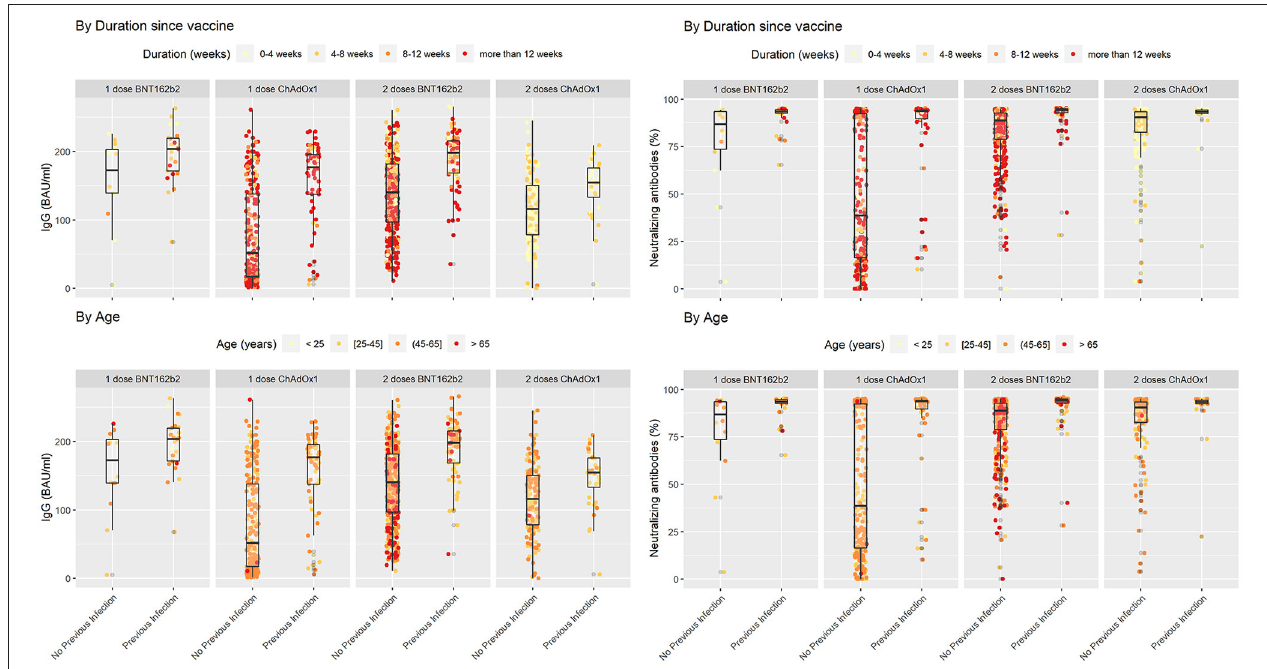
FIGURE 1 | SARS-COV2 IgG and neutralizing antibodies in vaccinated individuals stratified by previous infection status while duration since vaccination and age variations shown based on color coding. In each subgroup individuals with previous COVID-19 infection showed higher levels of IgG and Neutralizing antibodies in comparison with their counterparts who did not encounter COVID-19. Lower levels of IgG seem to be associated with a cluster of older individuals who received two doses of BNT162b2 without previous